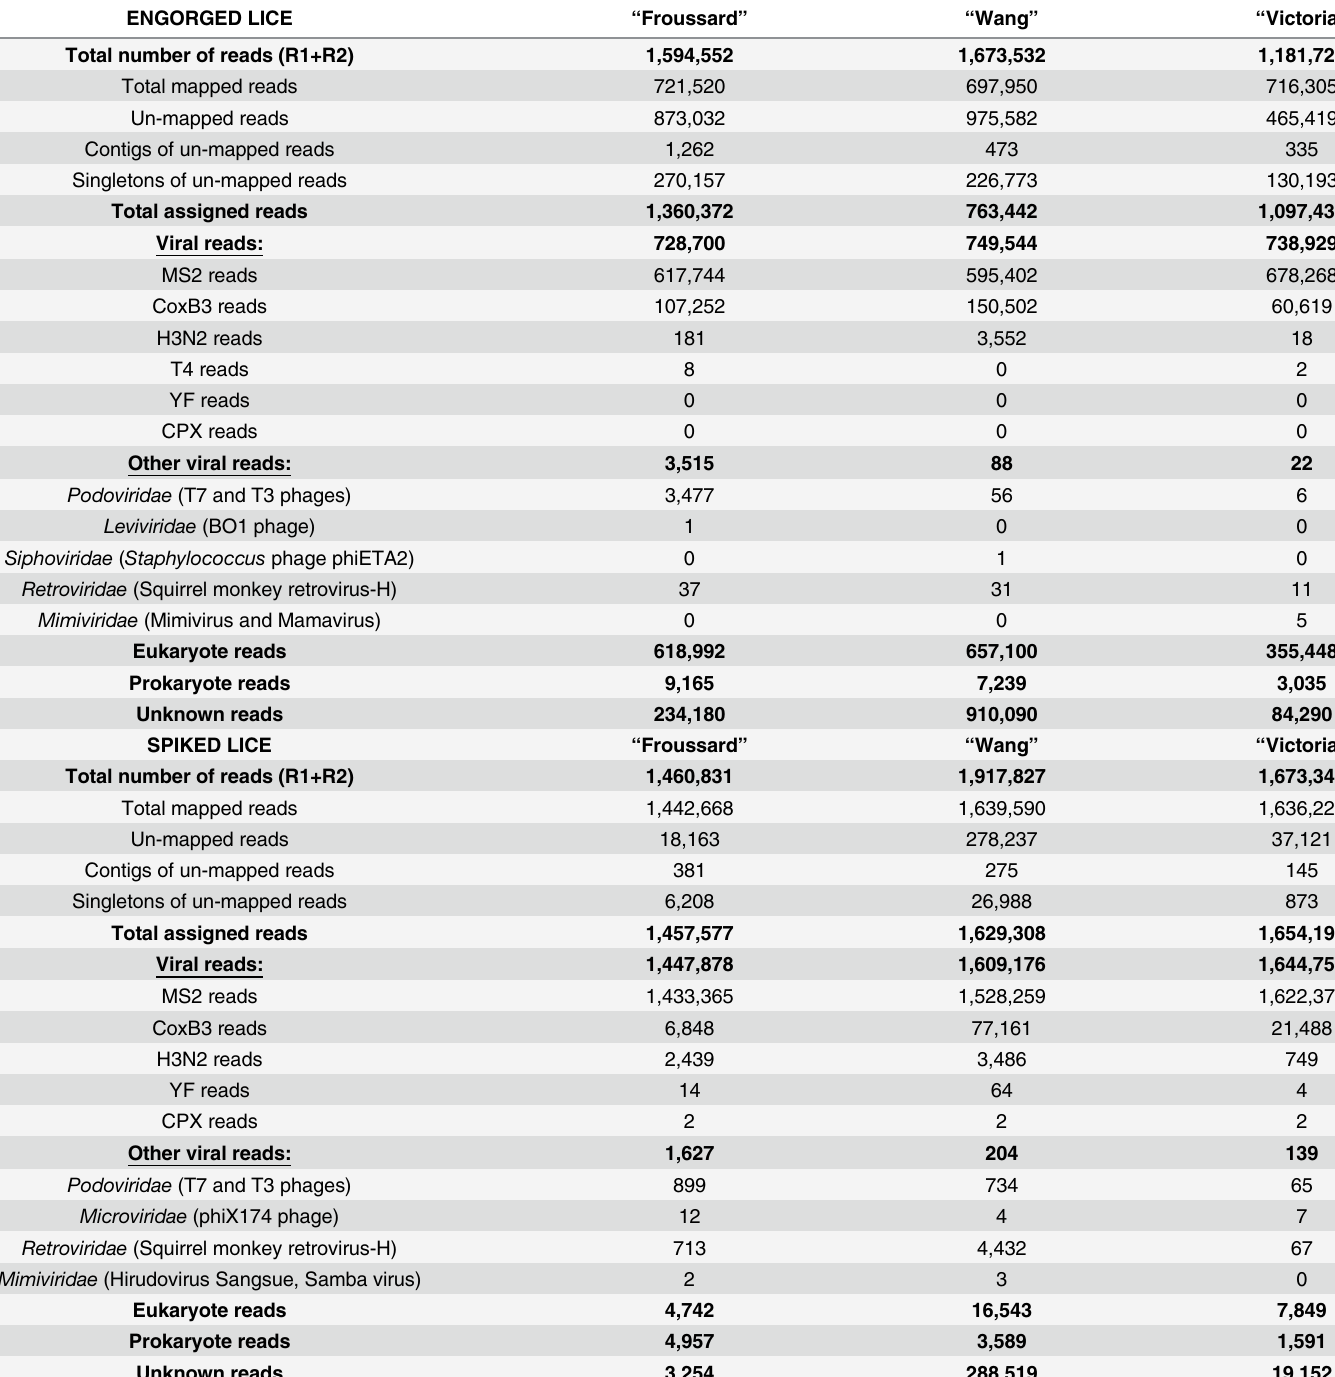
Table 2. Data of the Illumina MiSeq sequencing of engorged and spiked lice according to the random PCR method. ENGORGED LICE “ Froussard ” “ Wang ” “ Victoria